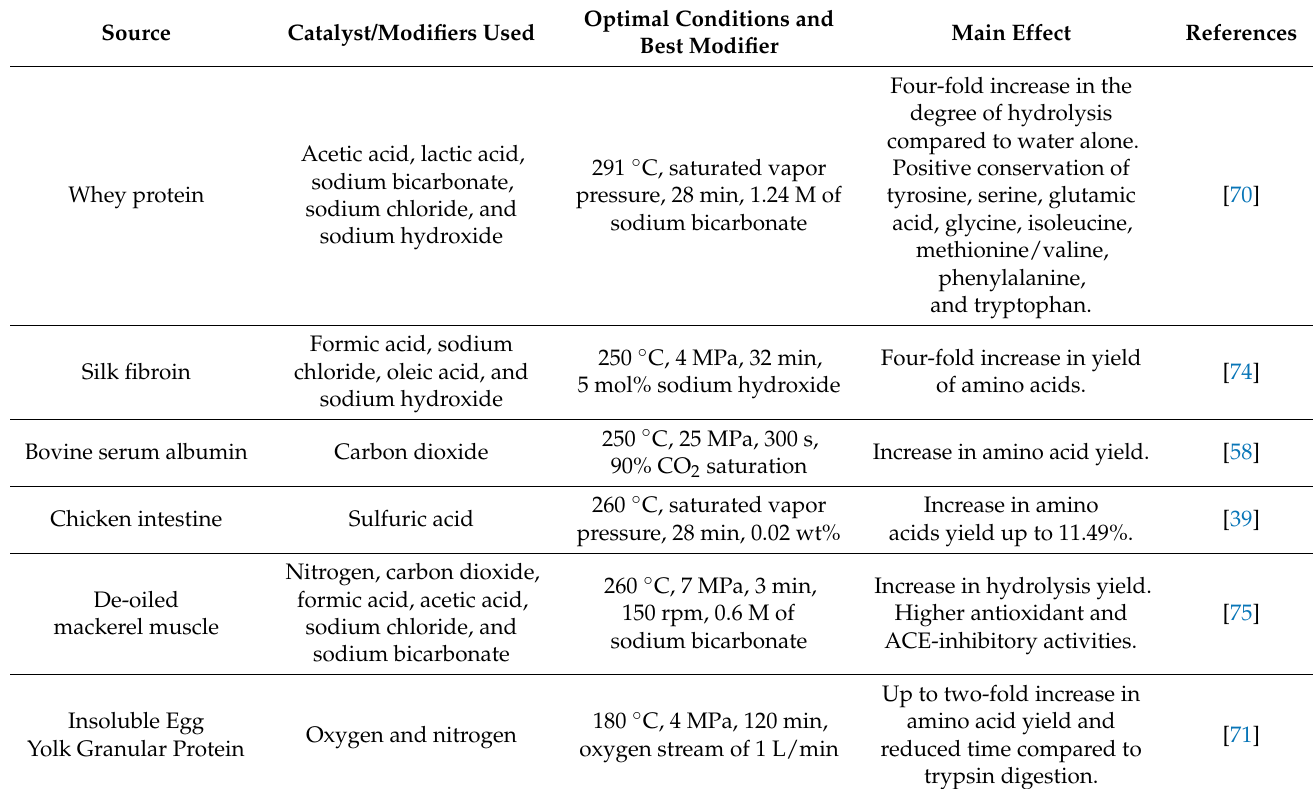
Table 2. Modifiers and their effects on protein hydrolysis by subcritical